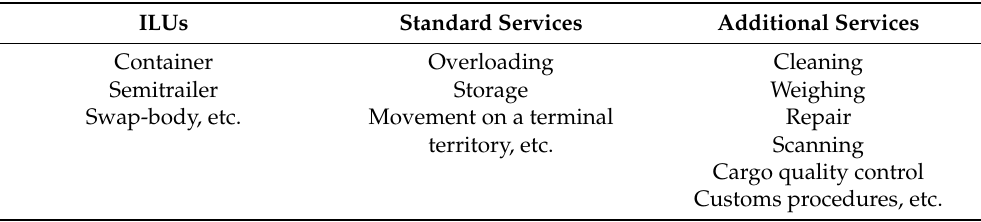
Table 1. Exemplification of selected services performed as part of ILU operations at transshipment terminals. ILUs Standard Services Additional Services Container Semitrailer Swap-body, etc.